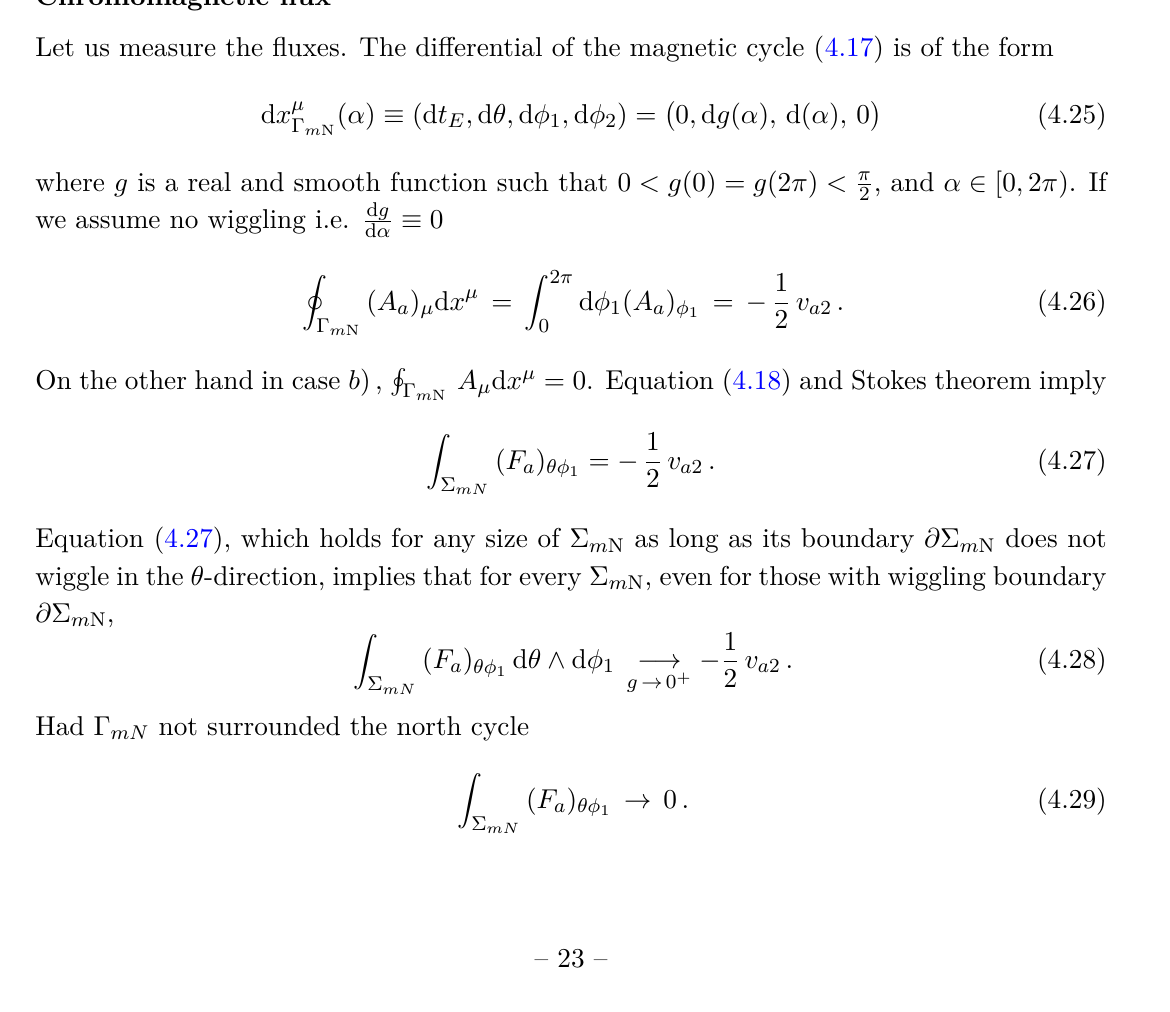
(resp. Γ ). The ribbons represent eN eS Γ . The figure to the right corresponds e − m θ =0 ( Γ eN eS